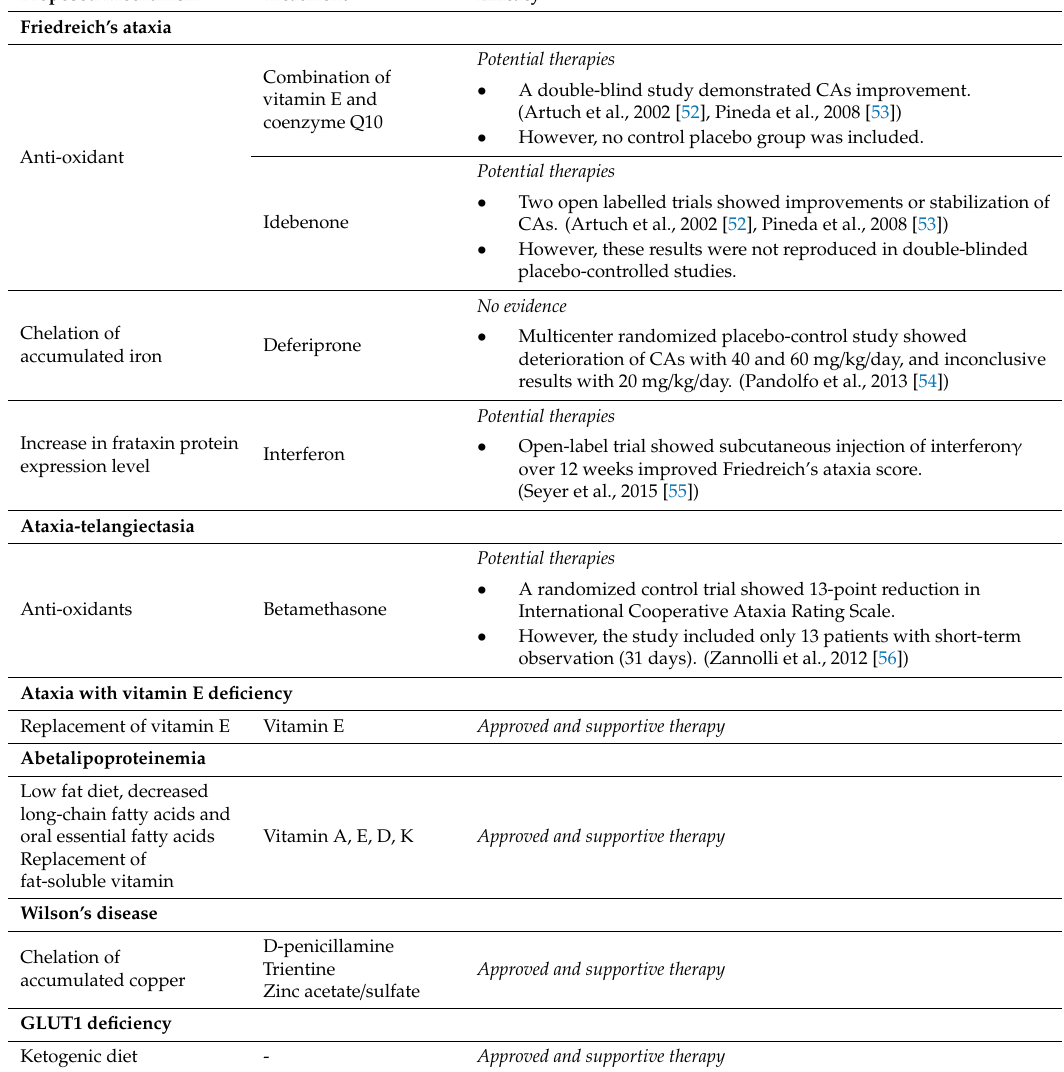
Table 2. Therapies for autosomal recessive cerebellar